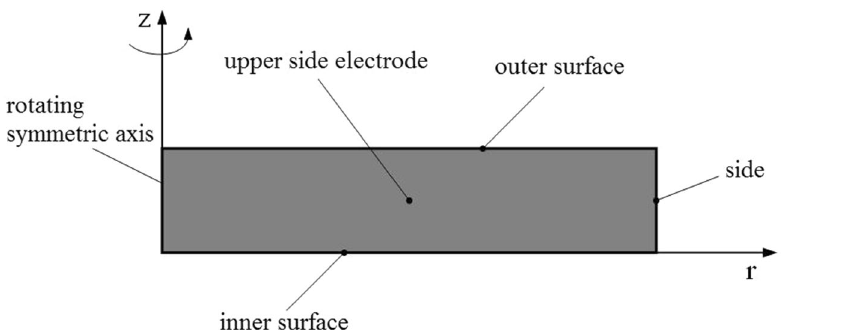
Figure 7. Electrode surface diagram of electrostatic